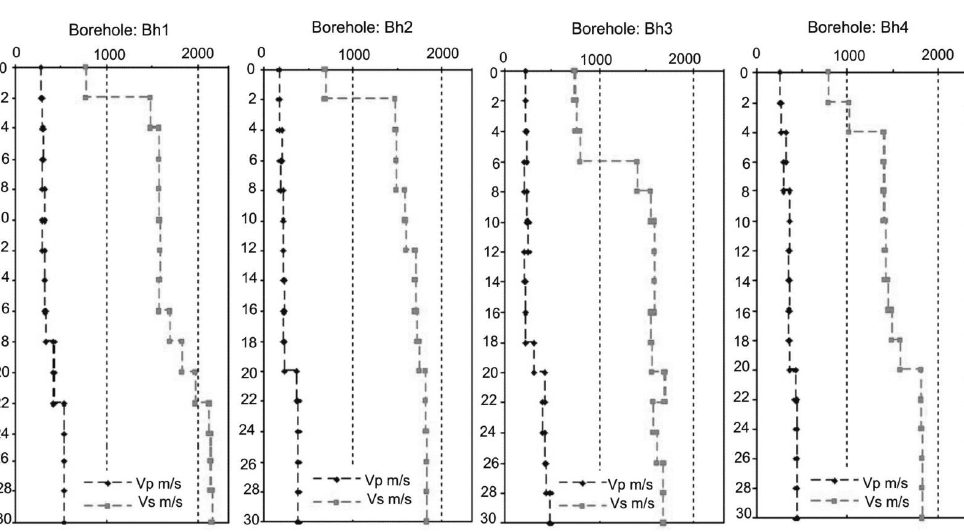
Fig. 6. S-wave and P-wave velocities in boreholes throughout Rasht